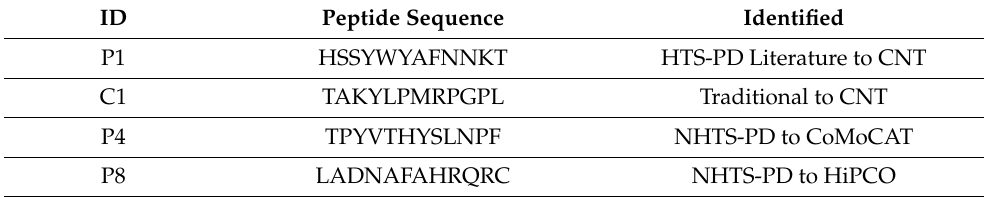
Table A2. Identified peptide sequences used in binding characterization experiments.